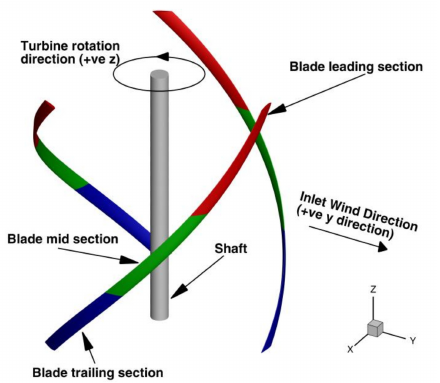
Figure 15. Sections of blades of a helical vertical axis wind turbine.